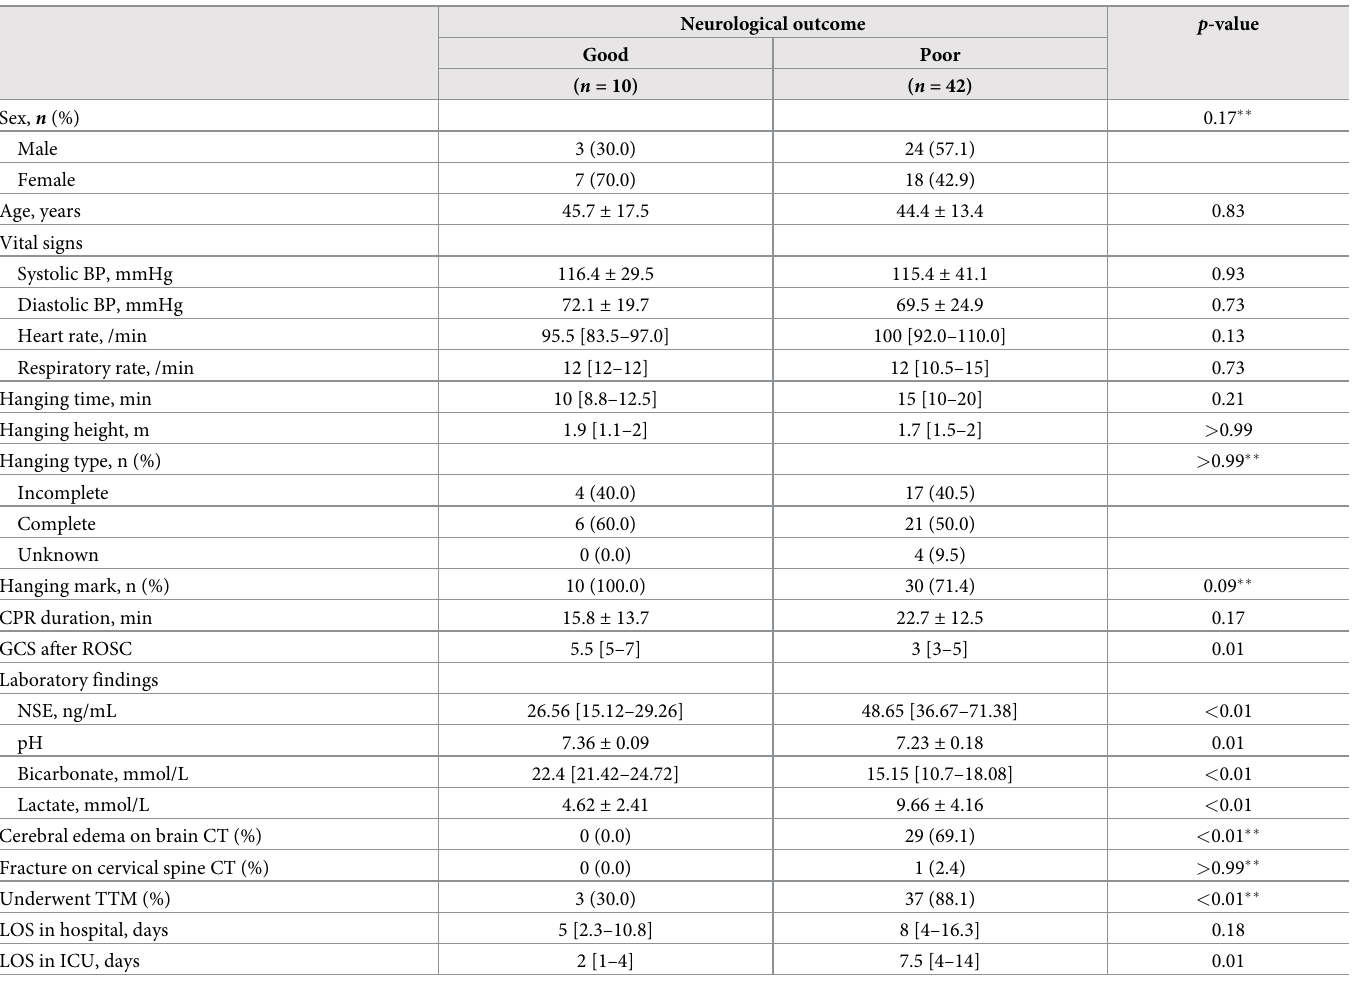
Table 3. Comparison between the good and poor neurological outcome near-hanging patients with cardiac